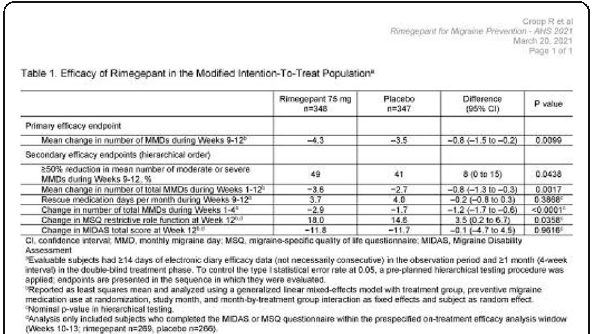
Table 1 (abstract AL054). See text for description